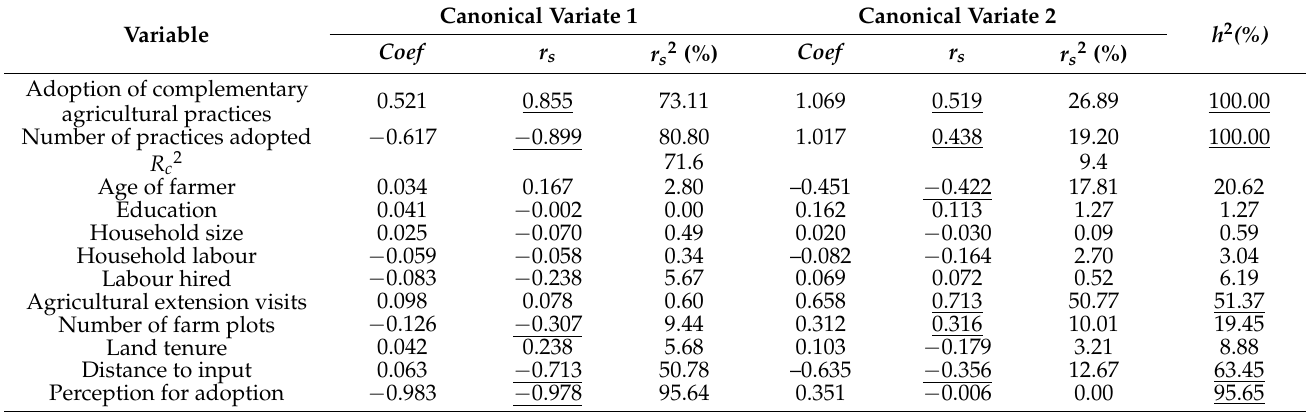
Table 3. Canonical solutions for adoption and intensity of adoption of agricultural practices for canonical variates 1 and 2. Note: Structure coefficients ( r s ) greater than I.30I are underlined. Communality coefficients ( h 2 ) greater than 45% are underlined. Coef = standardized canonical function coefficient; r s = structure coefficient; r s 2 = squared structure coefficient; h 2 = communality